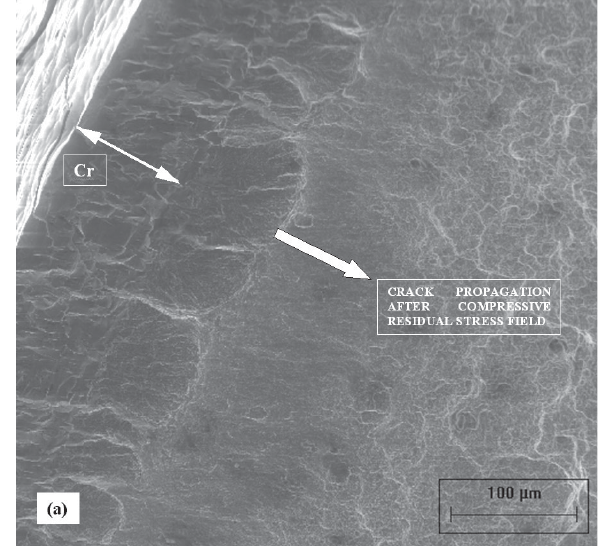
Figure 6a. Fracture surface of accelerated hard chromium elec- troplated specimen, 100 µ m thick, submitted to shot peening pre treatment.